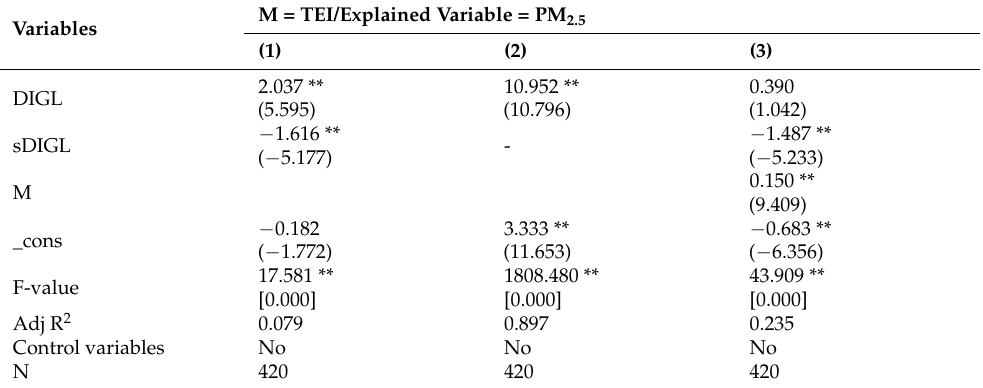
Table 6. Results of the analysis of TEI as a mediating